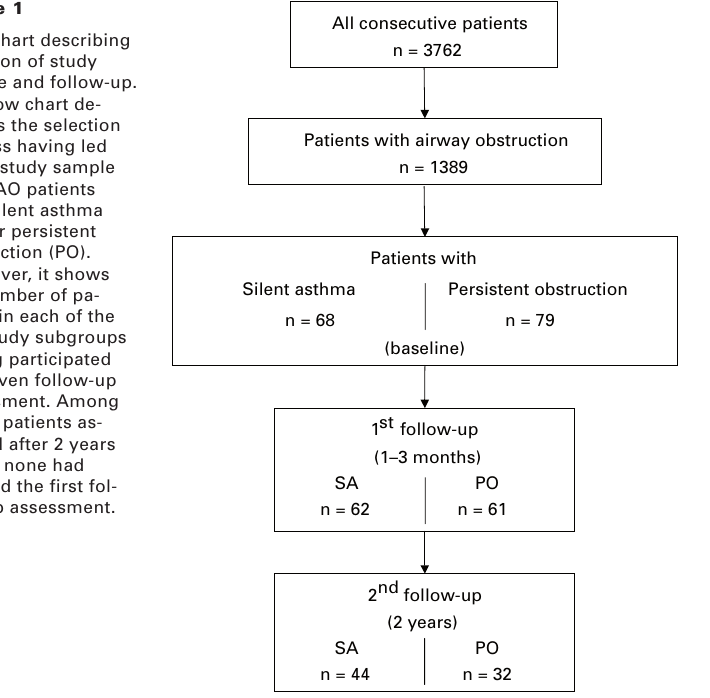
Figure 1 Flow chart describing selection of study sample and follow-up. The flow chart de- scribes the selection process having led to the study sample of UDAO patients with silent asthma (SA) or persistent obstruction (PO). Moreover, it shows the number of pa- tients in each of the two study subgroups having participated in a given follow-up assessment. Among the 76 patients as- sessed after 2 years (52%), none had skipped the first fol- low-up